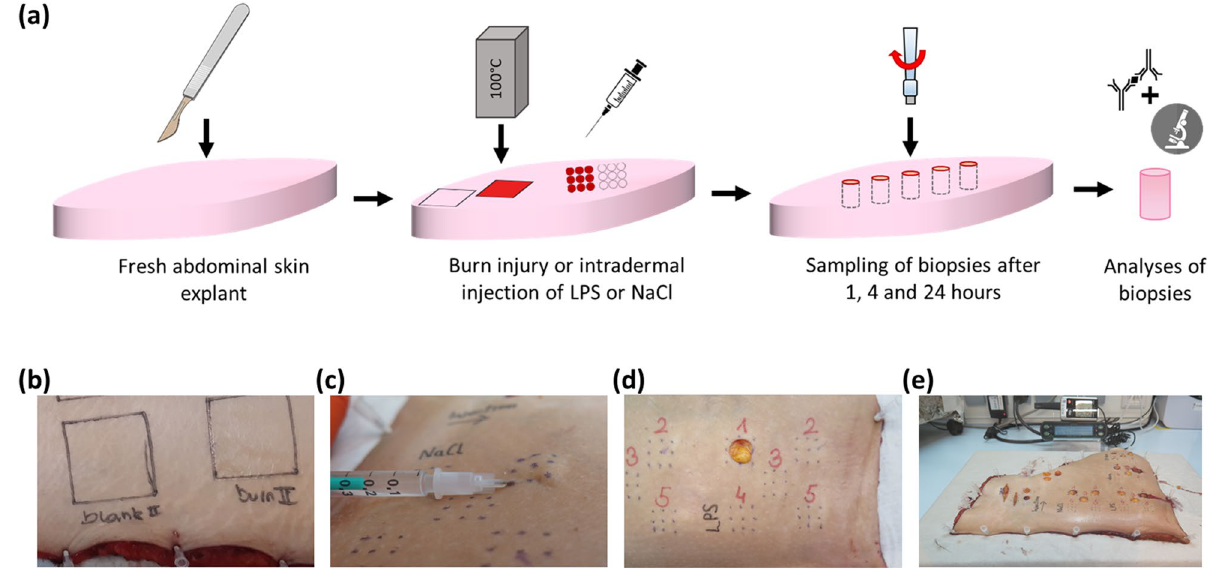
Figure 1. Experimental setup for the ex vivo skin model for burn injury and inflammation. ( a ) The experimental procedure included the immediate transfer of the fresh abdominal skin explants to the laboratory, creation of a burn injury or intradermal injection of LPS or NaCl, collecting punch biopsies and molecular and histological analyses. Representative pictures of ( b ) a burn injury (right field) compared with a healthy, blank site (left), ( c ) the intradermal injection of LPS (inflammation; red circles in (a)) or NaCl (control for injection trauma; open circles in (a)), ( d ) sampling of biopsies and ( e ) the skin explant in the climate